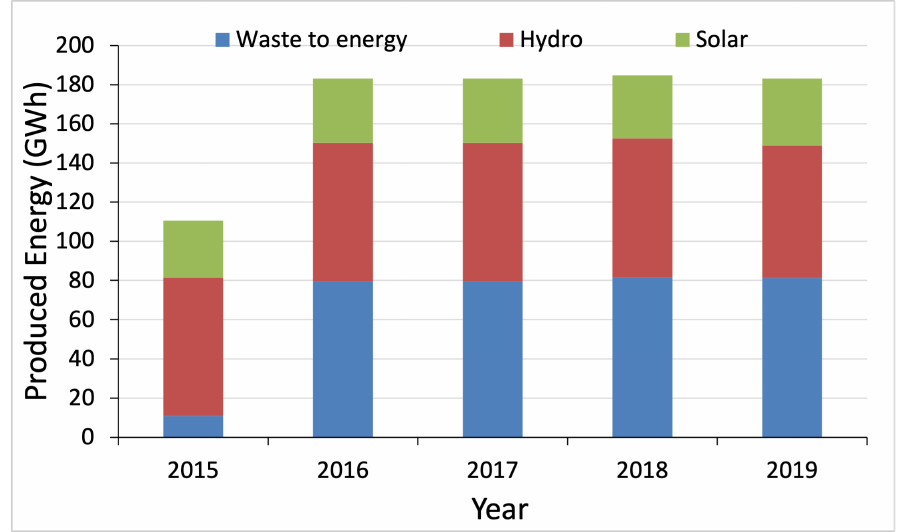
Figure 4. Energy mix